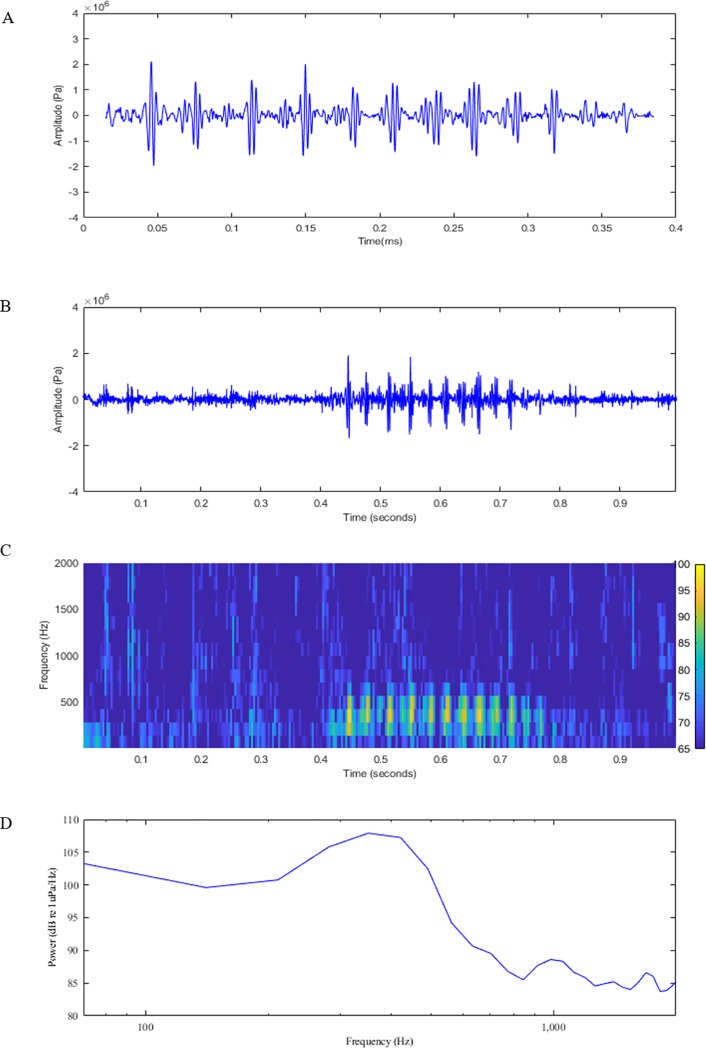
Acoustic visualisations of the John Dory bark.(A) zoomed waveform showing multiple pulses; (B) waveform showing multiple pulses; (C) spectrogram showing the frequency bandwidth; and (D) spectra showing the peak frequency.